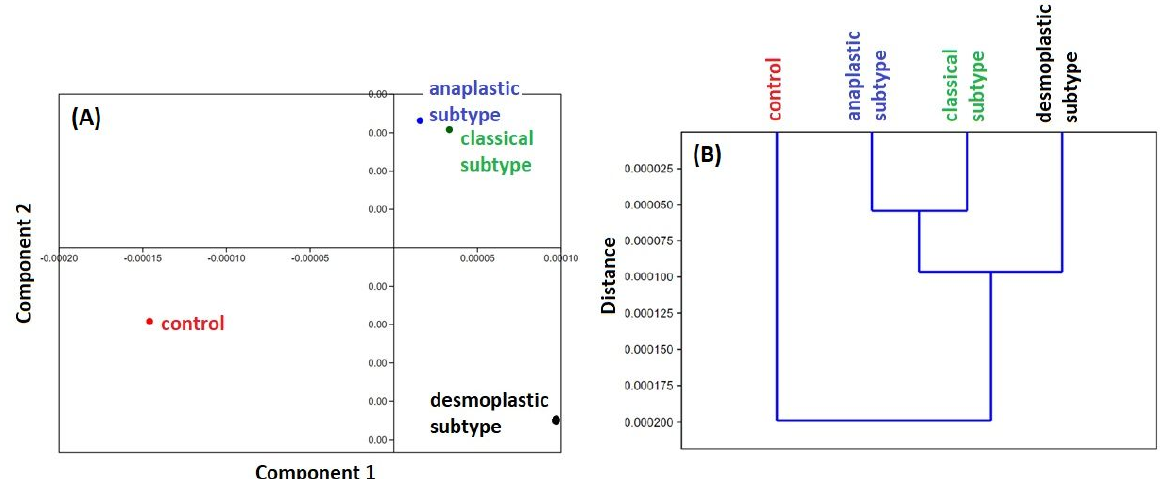
Figure 2. PCA ( A ) and HCA ( B ) analysis from ATR-FTIR spectroscopy of the controls and the three histological MB subtypes: (1) classic (green), (2) desmoplastic/nodular (black), (3) large cell/anaplastic (blue). Two-dimensional (2D) scores plot of samples with differences in biochemical components presented in fingerprint region. The analyses were performed on second derivative spectra.